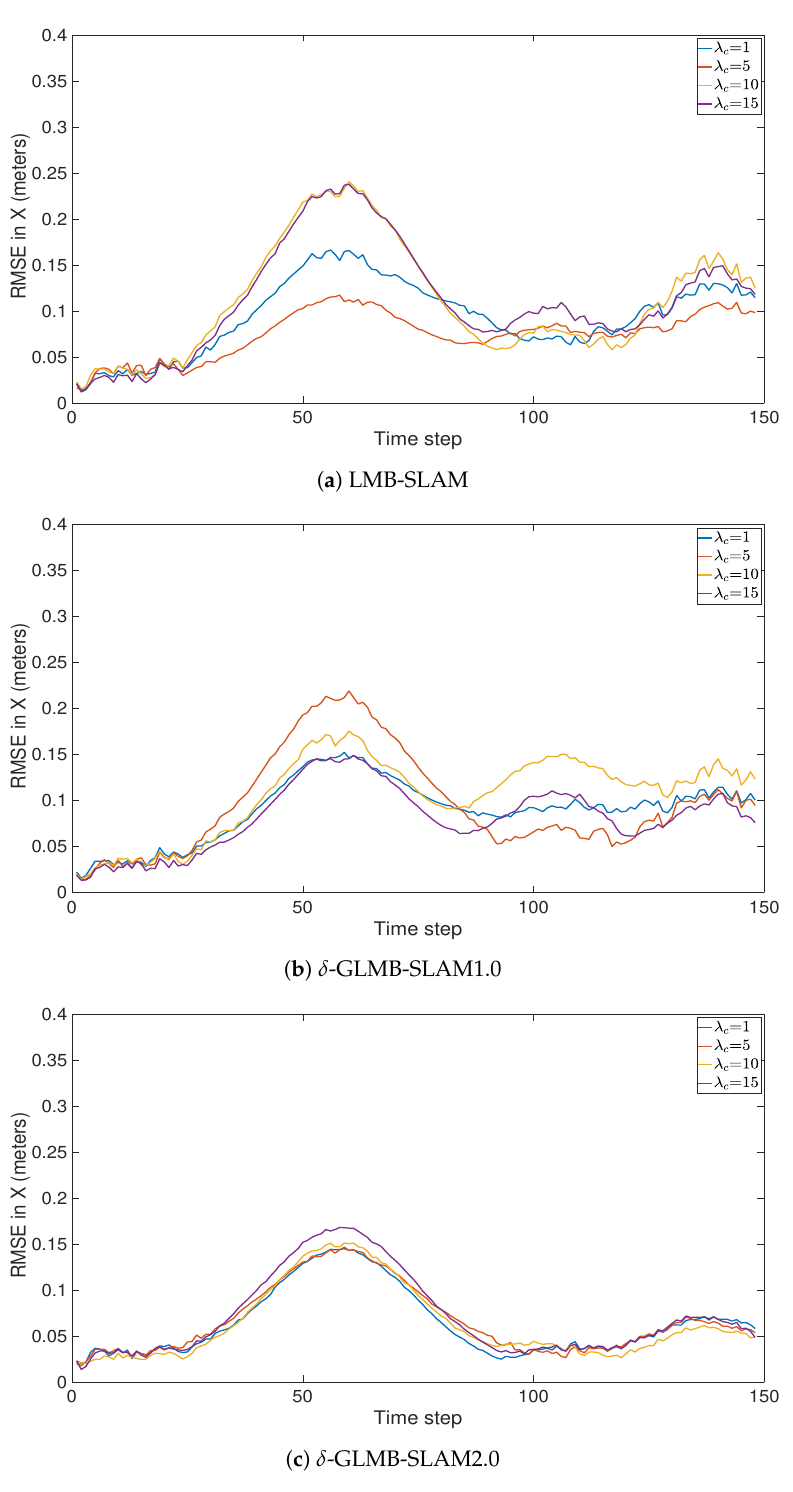
Figure 2. Comparison of RMSE in the X direction under varying clutter